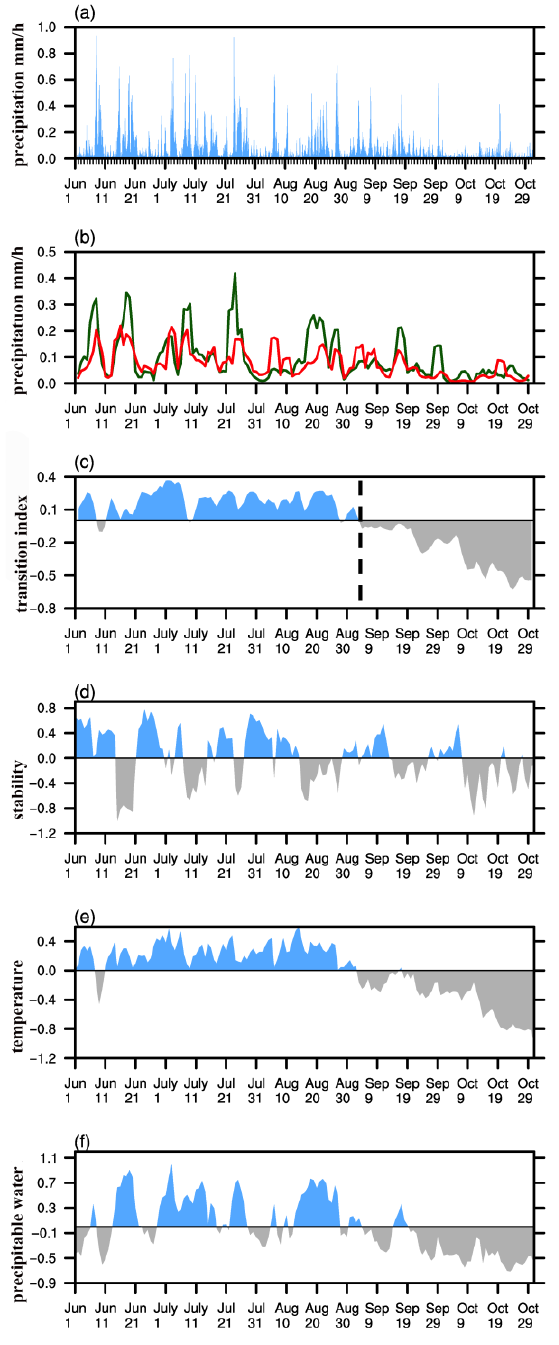
Figure A5. For June–October 2013, ( a ) hourly domain (white box in Figure 1a) averaged precipitation; ( b ) 3-day running mean of nighttime (20:00–08:00, dark green line) and daytime (08:00–20:00, red line) rainfall; ( c ) 3-day running mean of transition index anomaly (TI); normalized domain averaged ( d ) atmospheric stability anomaly, ( e ) 2 m temperature anomaly, and ( f ) precipitable water anomaly. The black dashed line in ( c ) indicates transition date 4 September 2013.